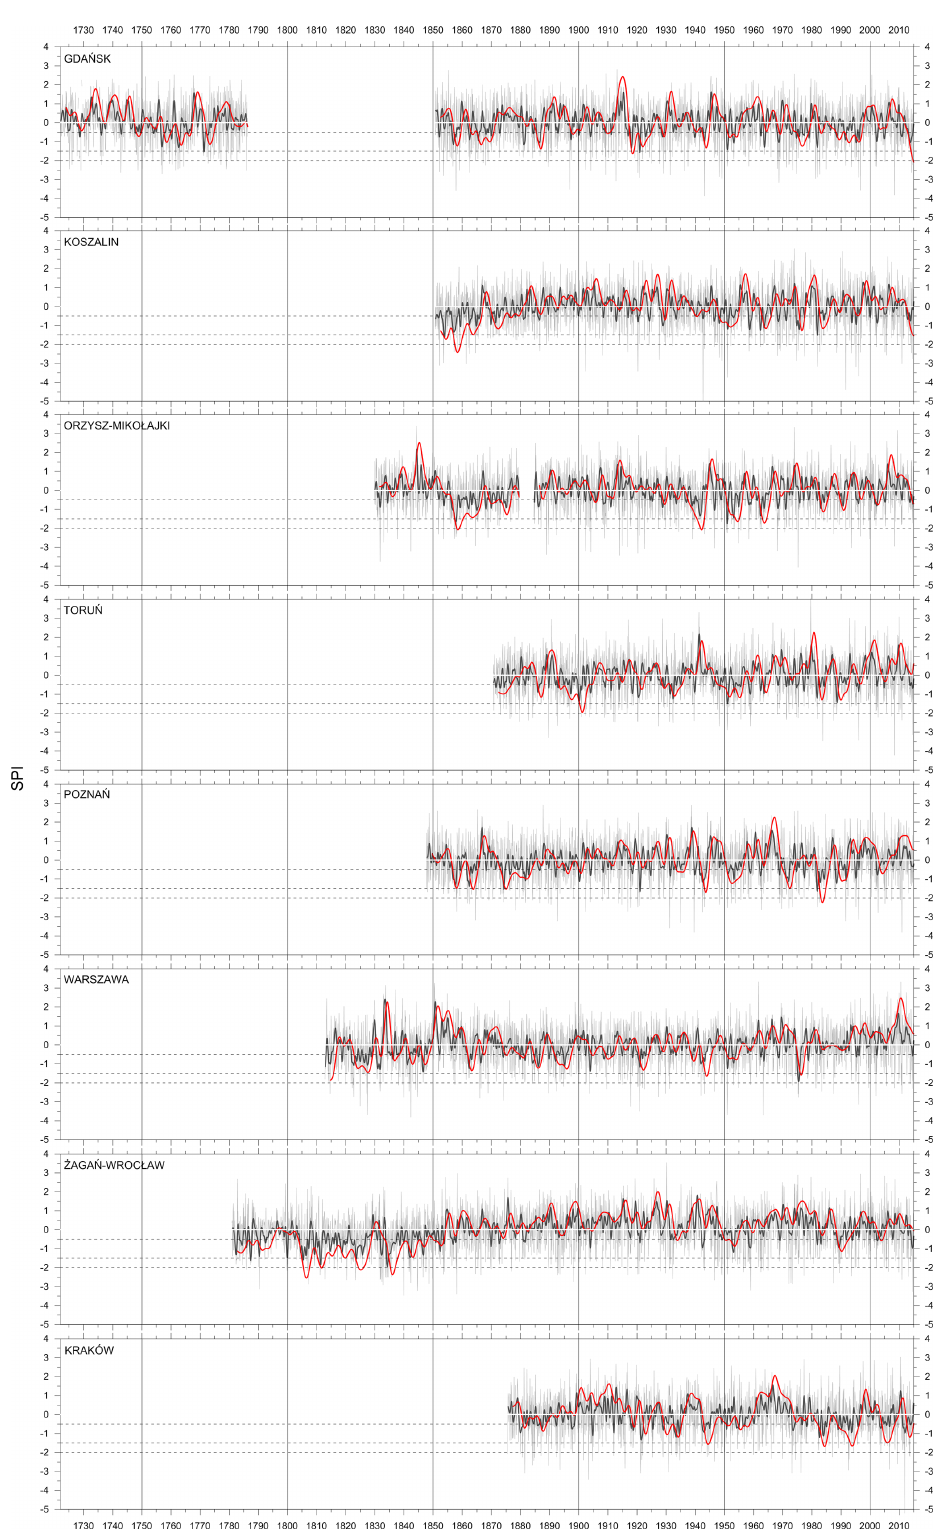
Figure 8. Variability in SPI: 1-month (grey curve), 3-month (black curve), and 24-month (red curve) variabilities calculated from the Polish instrumental series listed in Table 2 (oriented from north to south) in the period 1722–2015. SPI3 and SPI24 were filtered by 10-element and 30-element low-pass Gauss filters, respectively. Dashed lines indicate thresholds taken for distinguishing drought categories (see Sect.